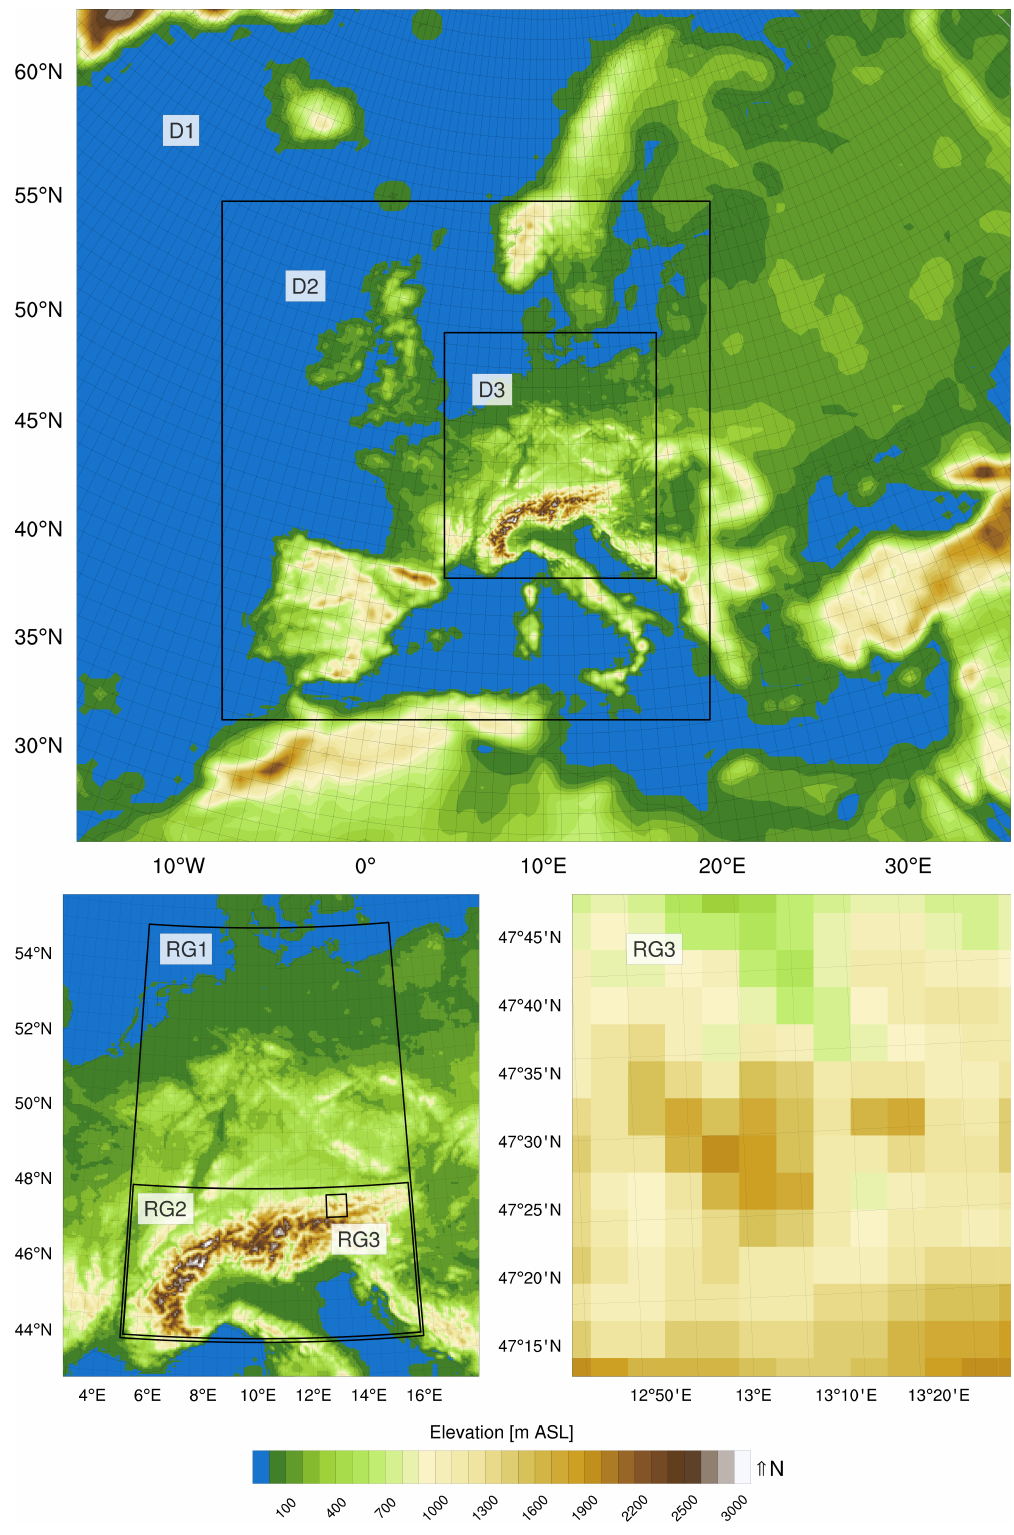
Figure 1. WRF domain configuration and nesting strategy (top): Domain 1 (D1: 45 km), Domain 2 (D2: 15 km), and Domain 3 (D3: 5 km). The investigated regions (bottom left), and a closeup of RG3 and the 5 km WRF terrain model (bottom right) are displayed. The black boxes in the bottom left figure mark the three regions that are focus of the study: RG1 (parts of Central Europe, Germany and the Alps), RG2 (the Alps and its surroundings), and RG3 (the Berchtesgaden Alps in South-East